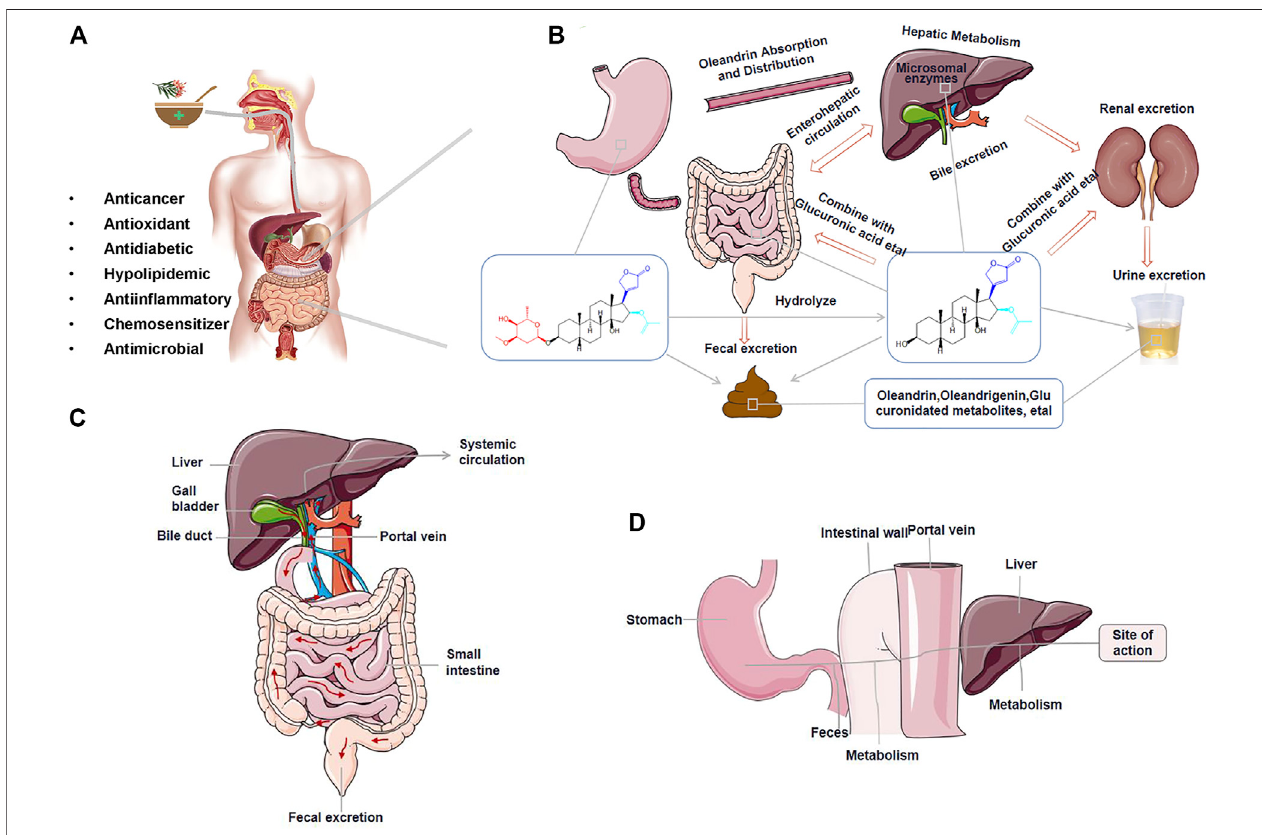
FIGURE 3 | The absorption, distribution, metabolism, and excretion (ADME) process of oleandrin. (A) Pharmacological properties of oleandrin. (B) Detailed ADME process of oleandrin in vivo . (C) The possibility of bile excretion and enterohepatic circulation (EHC) of oleandrin in vivo . (D) The possible fi rst-pass effect.